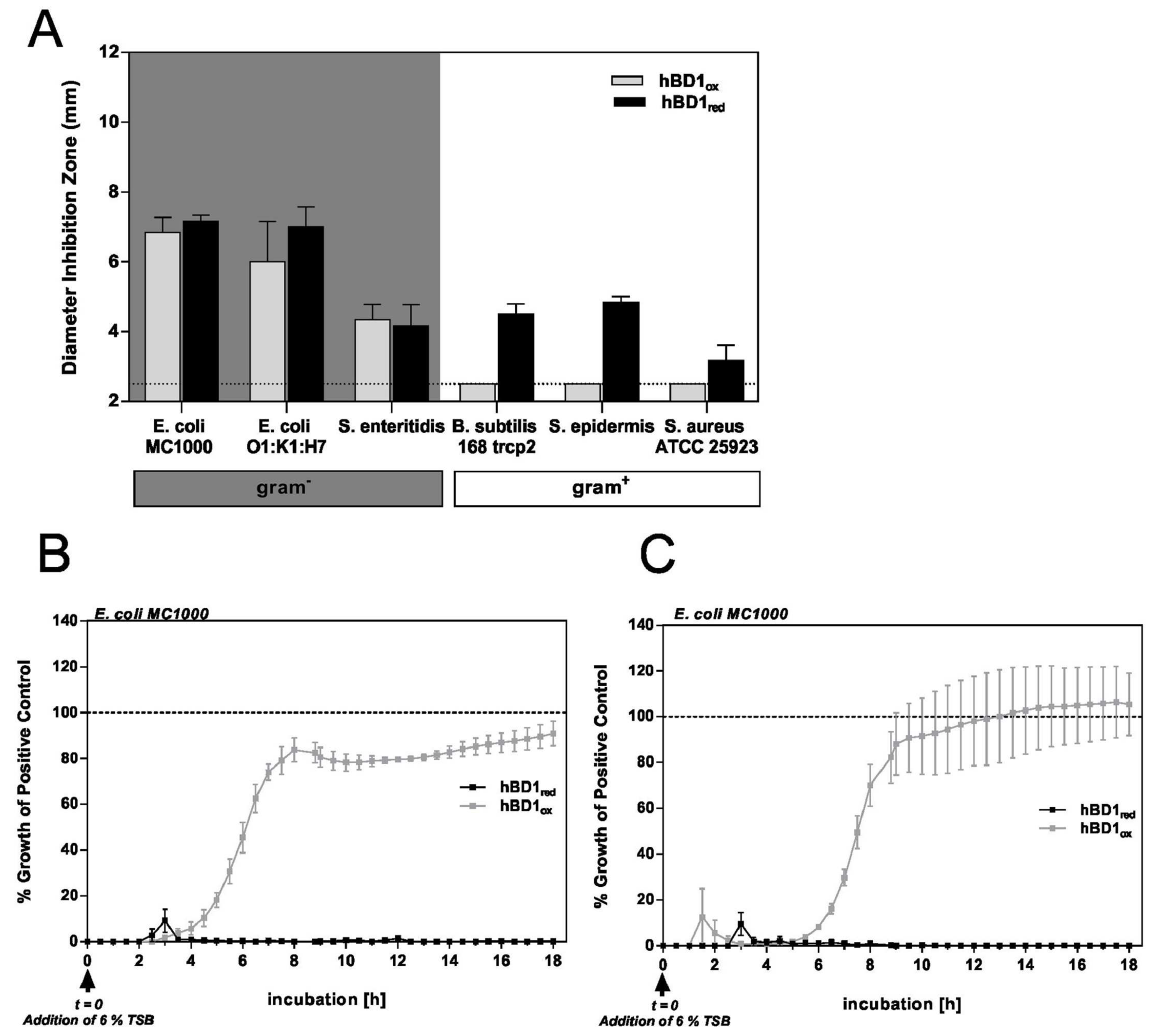
Fig 1. Antimicrobial activity of hBD1 is dependent of its redox status. Bacteria were incubatedwith hBD1ox and hBD1redin (A) RadialDiffusion Assay. Antimicrobial activity was measuredby analyzingthe diameterof the inhibitionzone. A diameter of 2.5 mm (dotted line) is the diameter of the punchedwell (n = 3). As it is not possibleto distinguishbetweena bactericidal and a bacteriostatic mechanismusing RDA as an end-pointdetermination, we additionally performed a time-course in a turbidity broth assay. Bacteria were pretreatedwith 62.5 μ M (B) and 125 μ M (C) of the peptidesbefore additionof 6% TSB and % growth of the untreatedcontrol over the following18 h was plotted. In contrast to hBD1red, the E . coli culture treated with hBD1ox is able to regrow with a delay of 4 h (B) and 5.5 h (C) comparedto the control. Data are presentedas mean +/- SEM of at least two (B+C) or three (A) independent experiments.